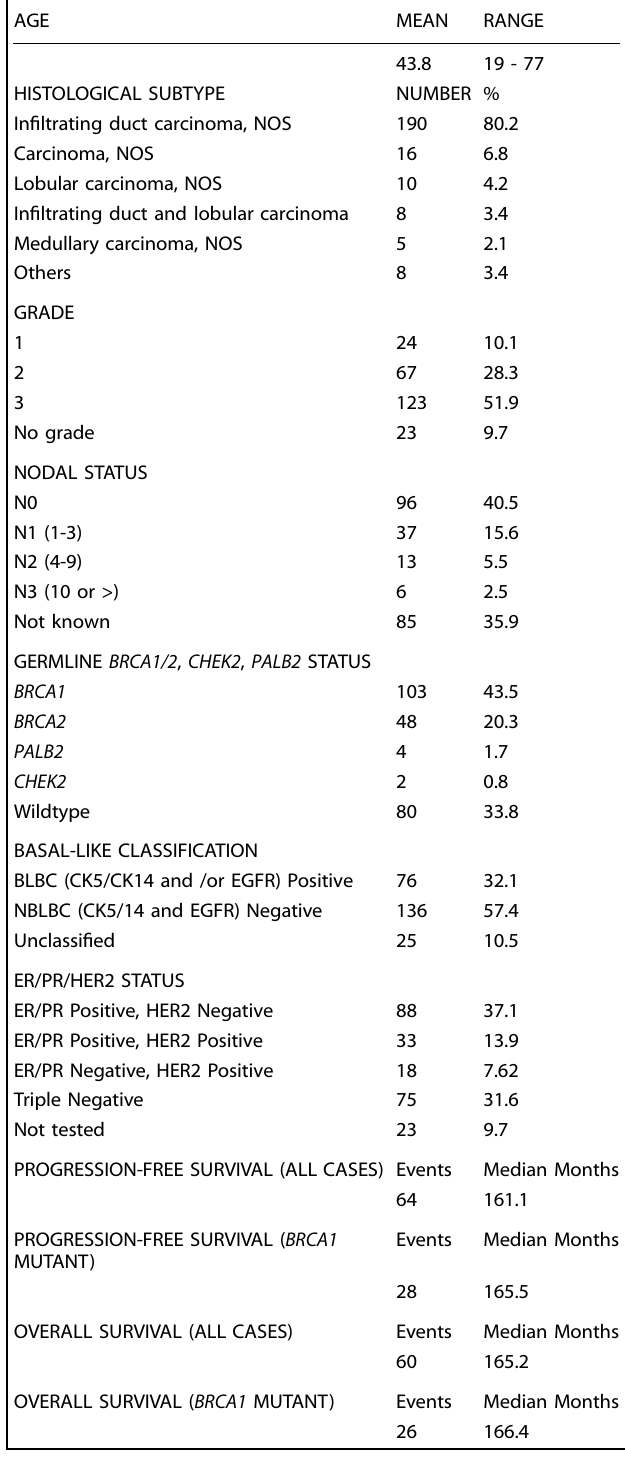
Table 1. Patient and Tumour